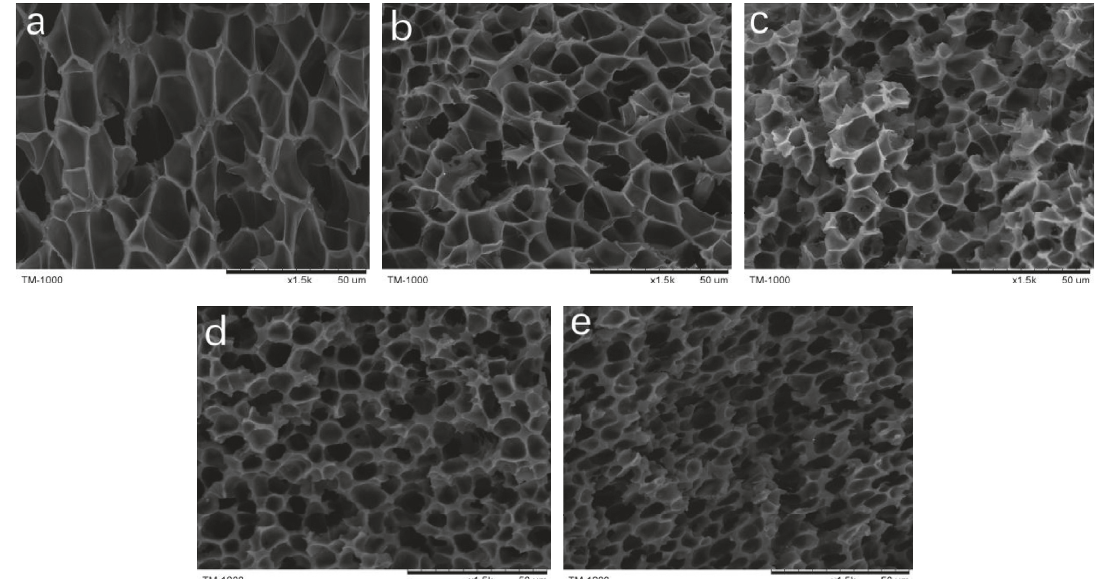
Figure 10: Cell structure of foaming material under different incubation times (110 ° C, 16MPa): (a) foaming time 0.5h, (b) foaming time 1h, (c) foaming time 2h, (d) foaming time 4 h, and (e) foaming time 8 h.